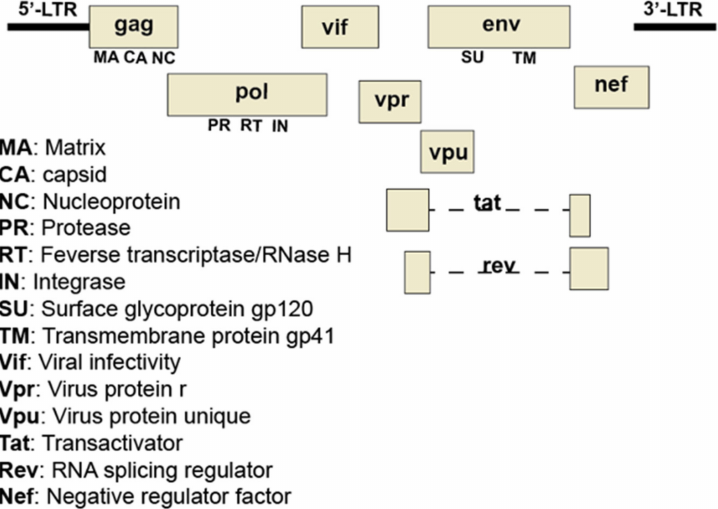
Figure 4. Organization of the HIV-1 genome. The HIV-1 genome consists of two identical copies of noncovalently linked, linear, positive-sense, single-stranded RNA molecules. Each identical copy contains nine genes that encode fifteen proteins. Many of the proteins are synthesized as precursor polyproteins which are proteolytically processed by host or viral proteases into individual proteins with roles in viral architecture, replication, regulation of cellular functions, and evasion of the host defenses. The gag gene encodes viral proteins involved in the structure of the virus. The pol gene encodes viral proteins critical for replication and integration of provirus into the host genome. The env gene encodes proteins needed for viral attachment and fusion with target